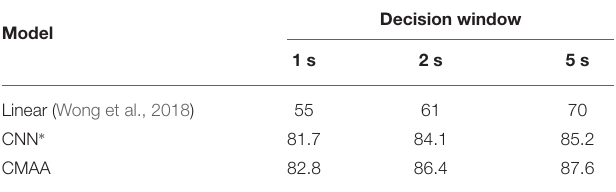
distributions produced by the cross-modal attention during its TABLE 1 | Auditory attention detection accuracy (%) in a comparative study of different models on the same DTU dataset with different window lengths under anechoic